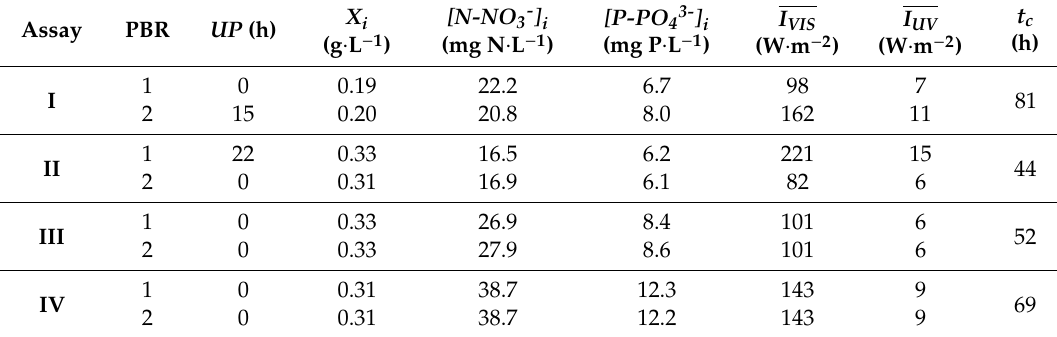
Table 1. Experimental conditions for each